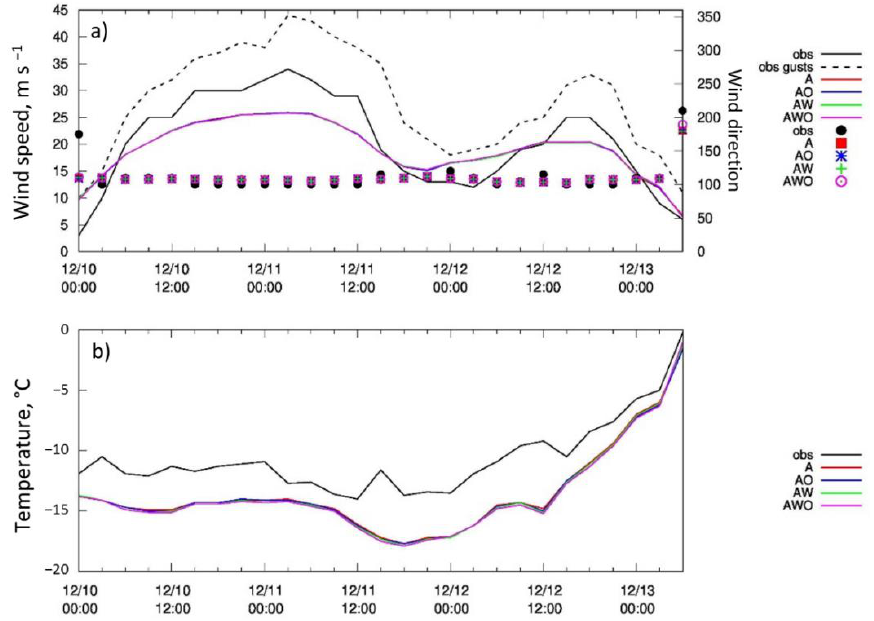
Figure 2. 10-m wind speed (solid lines), gusts (dashed line) and direction (markers) ( a ) and 2-m air temperature ( b ) from observations and simulations at the Malye Karmakuly weather station.